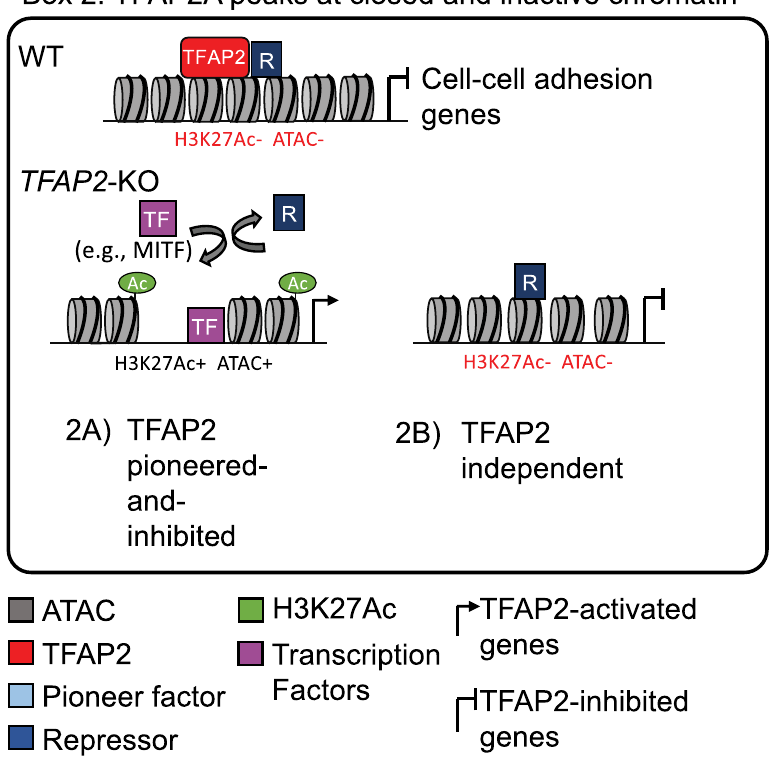
Fig 2. Categories of TFAP2-regulated enhancers. Box 1 : TFAP2A peaks at open and active chromatin. ( 1A ) TFAP2-pioneered-and-activated enhancers show reduced nucleosome accessibility (ATAC-seq) and reduced levels of active chromatin marks (H3K27Ac and H3K4Me3) in TFAP2-KO cells compared to in WT cells. We infer that TFAP2 paralogs pioneer chromatin access for transcriptional co-activators, like MITF and SOX10 (purple box), that in turn recruit chromatin remodelling enzymes and histone modifying enzymes. ( 1B ) Non-pioneered TFAP2-activated enhancers show loss of